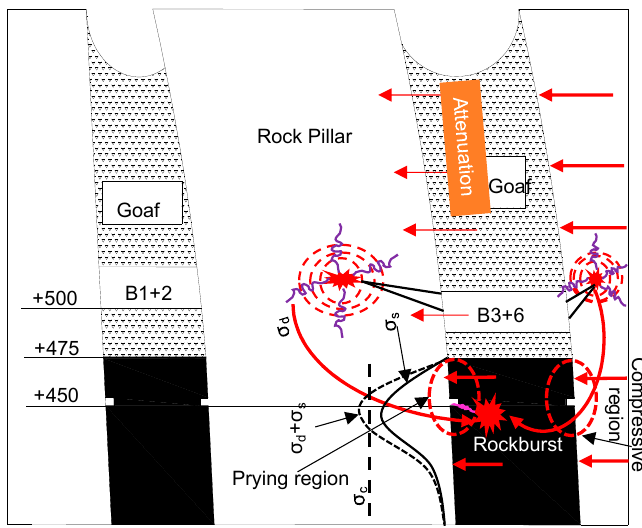
Figure 14. Principle of induced rockburst in a steeply inclined and extremely thick coal seam (SIETCS). σ s is the static stress, σ σ c is the critical value stress when rockburst d is the dynamic stress, and occurs